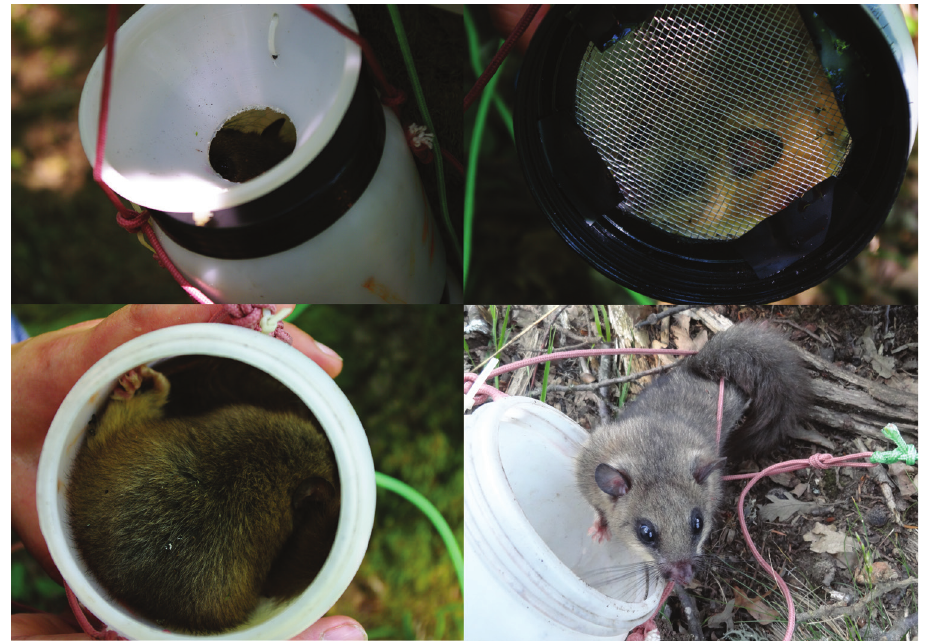
Figure 14. Dormouse captured in a baited trap at Foresta della Lama (2 July 2015). The photographs show that the animal survived in the trap due to the metallic net fixed between the bait chamber and the capture chamber (Photos by M. Bardiani and J. R ӧ